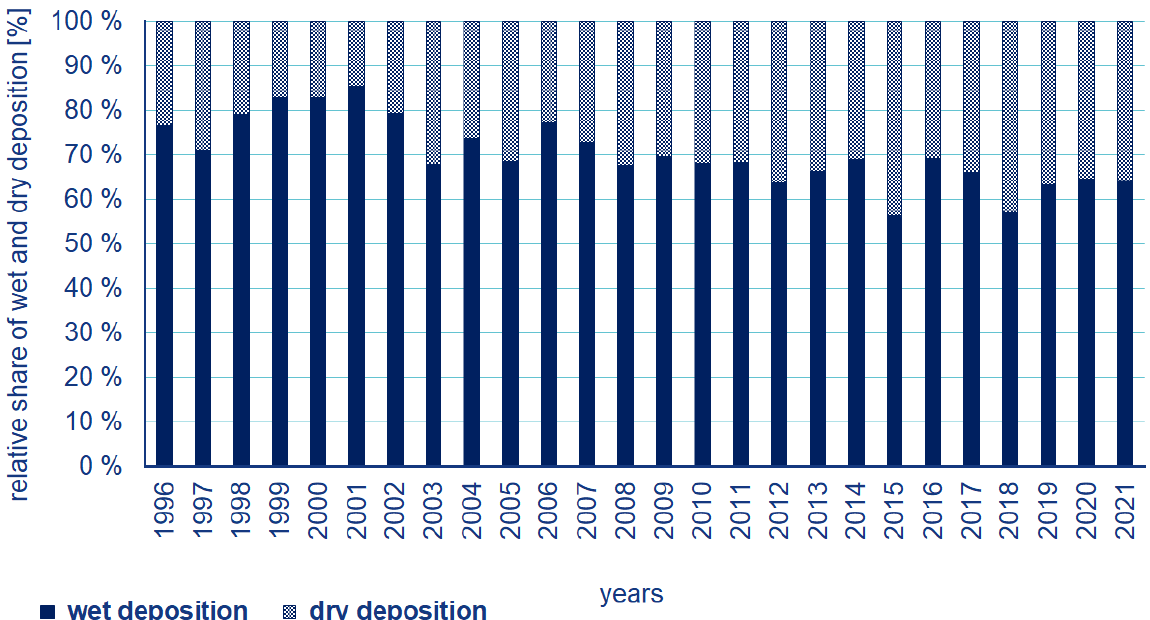
Figure 3. Estimate of annual total deposition of Pb over the entire area of the Czech Republic (78,841 km 2 ) based on data-driven geostatistic model, 1996–2021.